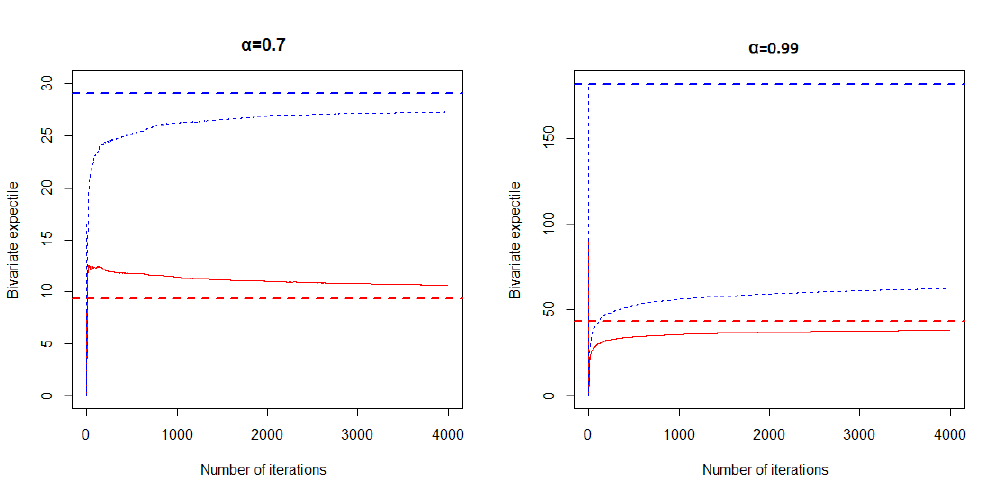
Figure 7: Convergence of the algorithm, L 1 − expectile, Pareto independent model ( a = 2 , red b 1 = 10 , blue b 2 = 20